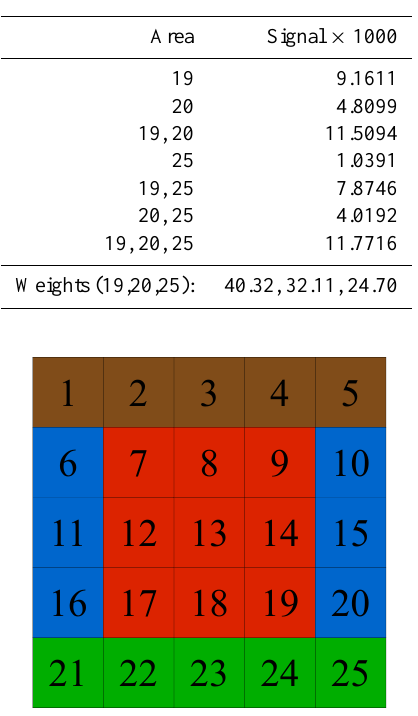
Table 3. Example signal list for elements 19, 20 and 25 in system 3. Parameter settings correspond to set 1 in Table 4.